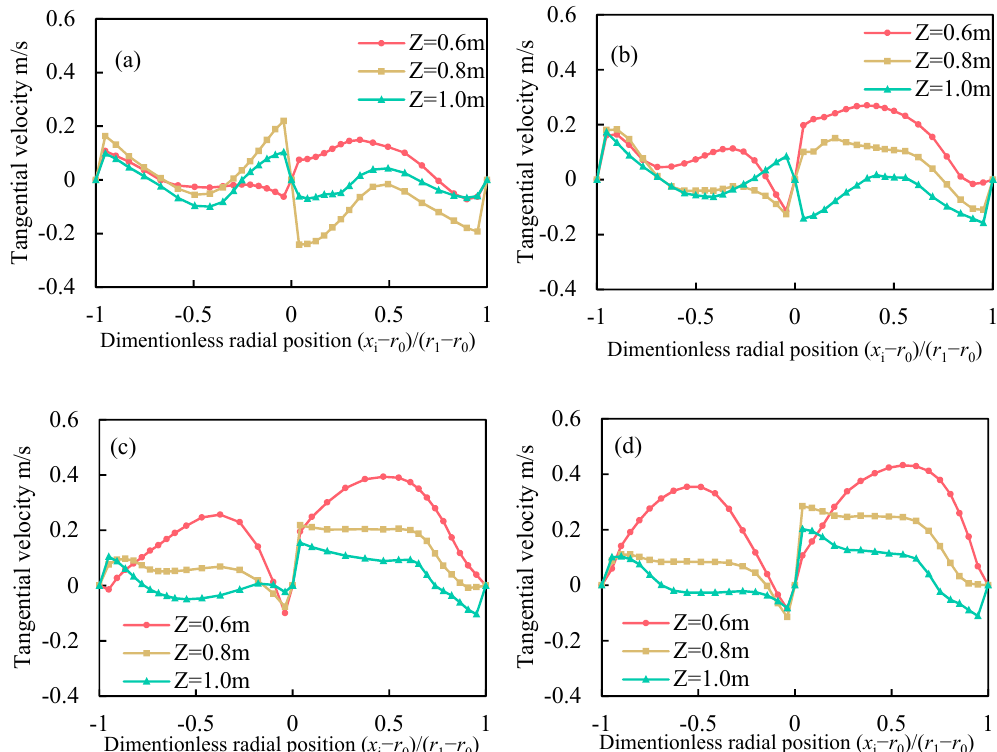
Figure 8. The tangential velocity of particles at different cross section: ( a ) h = 0.1 D h ; ( b ) h = 0.2 D h ; ( c ) h = 0.3 D h ; ( d ) h = 0.4 D h .